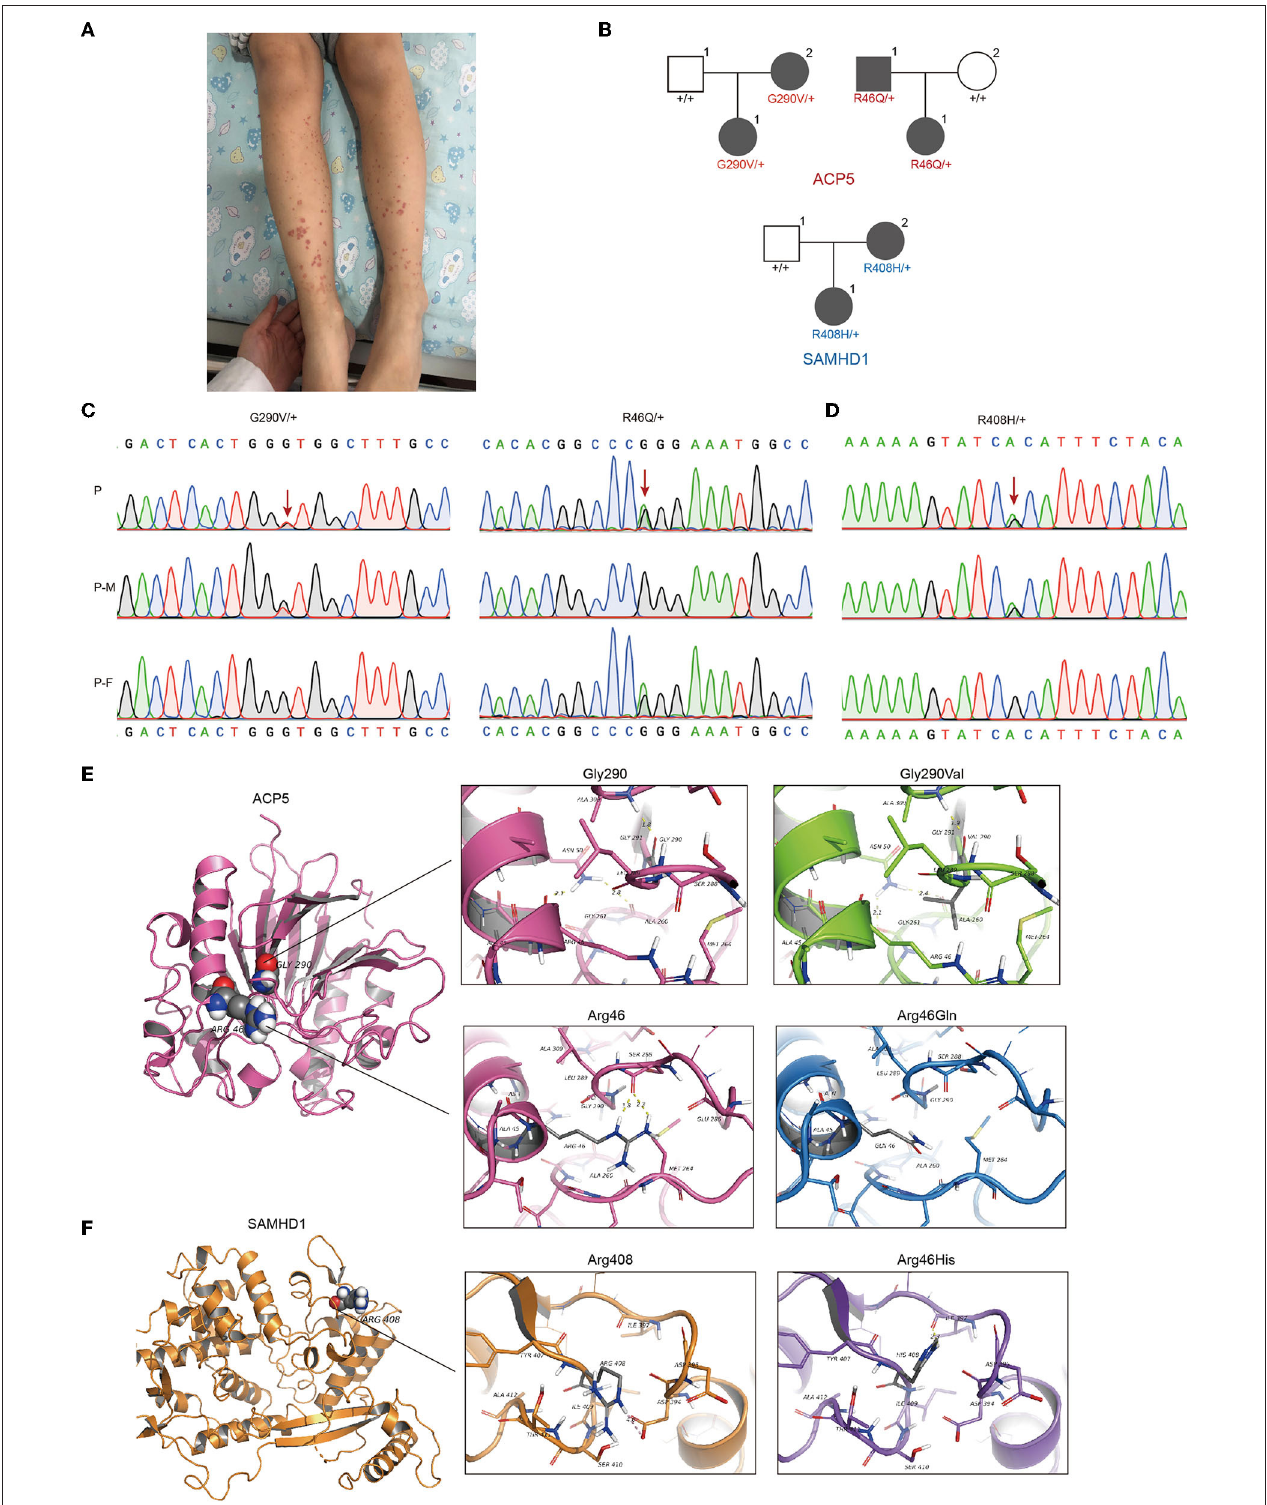
FIGURE 1 | Identification of gene mutations in patient with pSLE. (A) The patient initially presented skin bleeding spots in both lower limbs. (B) Pedigrees showing affected probands and parents. Sanger sequencing confirmation of the c.1152G > T (p.Gly290Val), c.420G > A (p. Arg46Gln) at ACP5 (C) and c.1423G > A (p.Arg408His) at SAMHD1 (D) variant identified in our patient using exome sequencing. Chromatograms represent the reference (top) and the mutant sequence. The